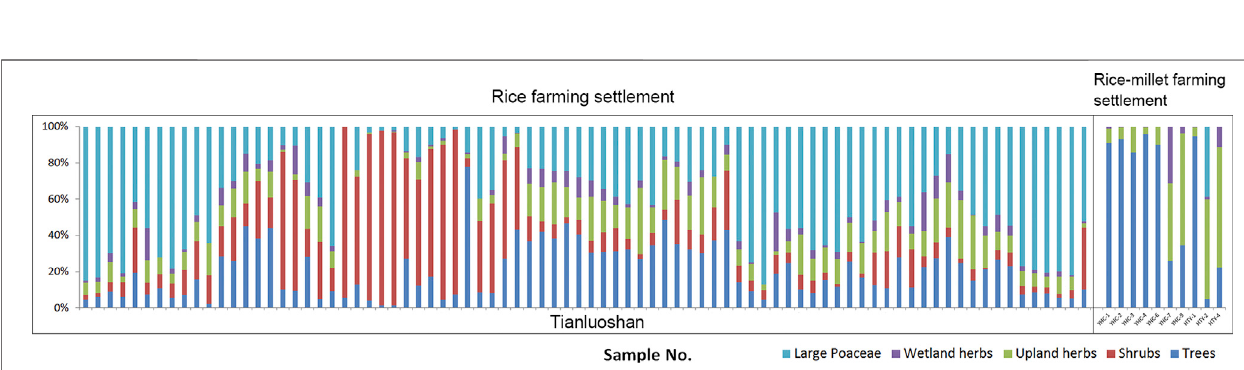
Frontiers in Earth Science |